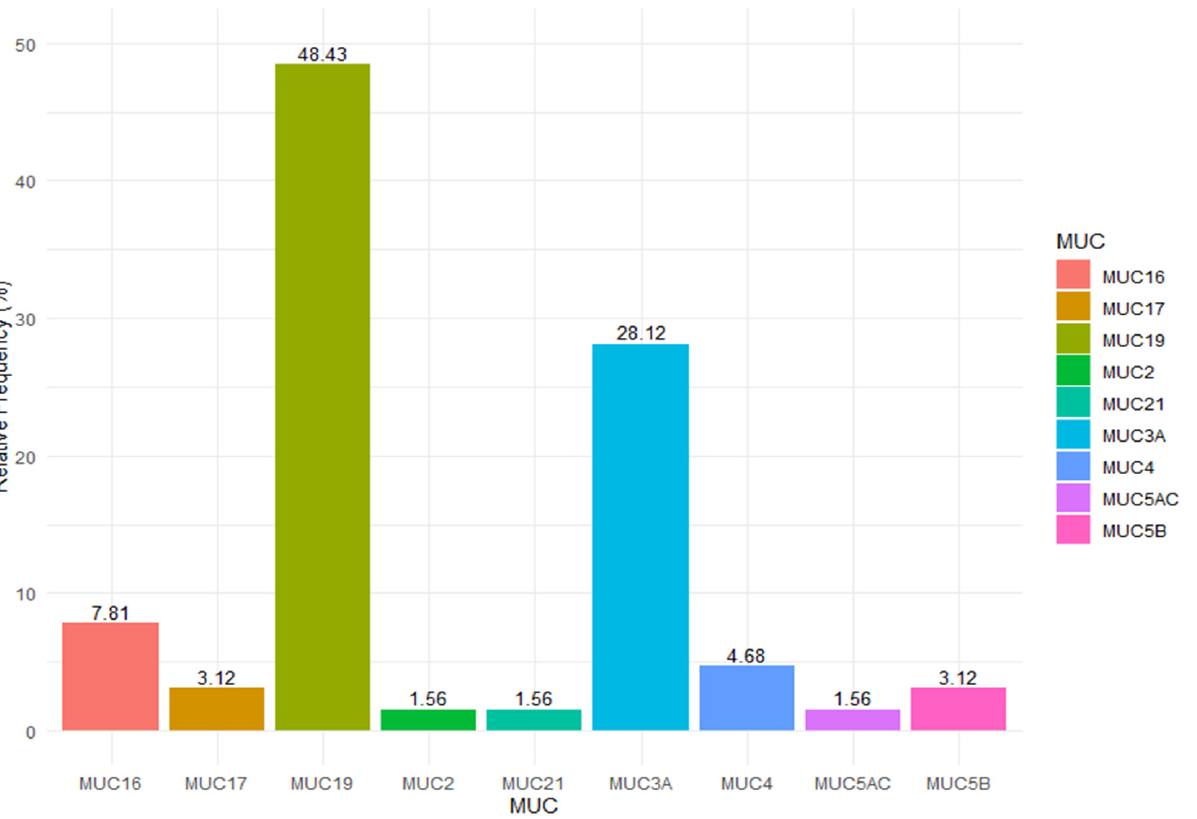
Figure 1. Frequency distribution of significant polymorphisms in each gene. Only 4 of these mutations were more frequent in the NAM group compared to the ALL group (rs60568788; rs2547065; rs10422567; and rs1559172) and 55 were unique to